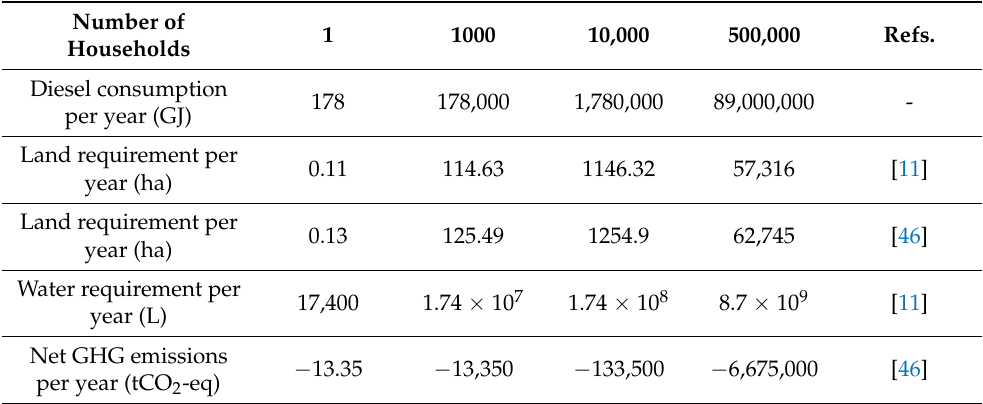
Table 2. Land and water requirements for microalgae biodiesel